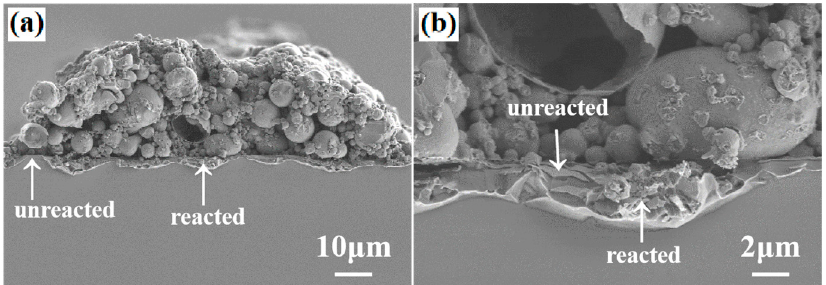
Figure 7. ( a ) SEM image at the Si/paste 1 interface after firing through reaction; ( b ) detailed SEM image showing non-uniform reactions at the Si/paste 1 interface.